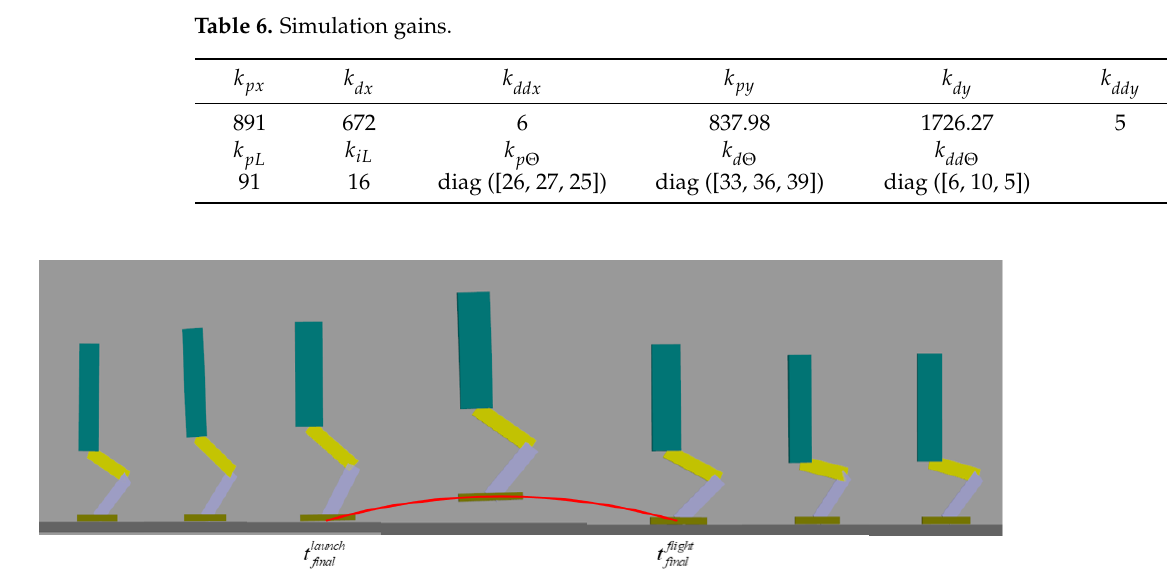
Figure 7. Screenshots of robot’s vertical jump motion.